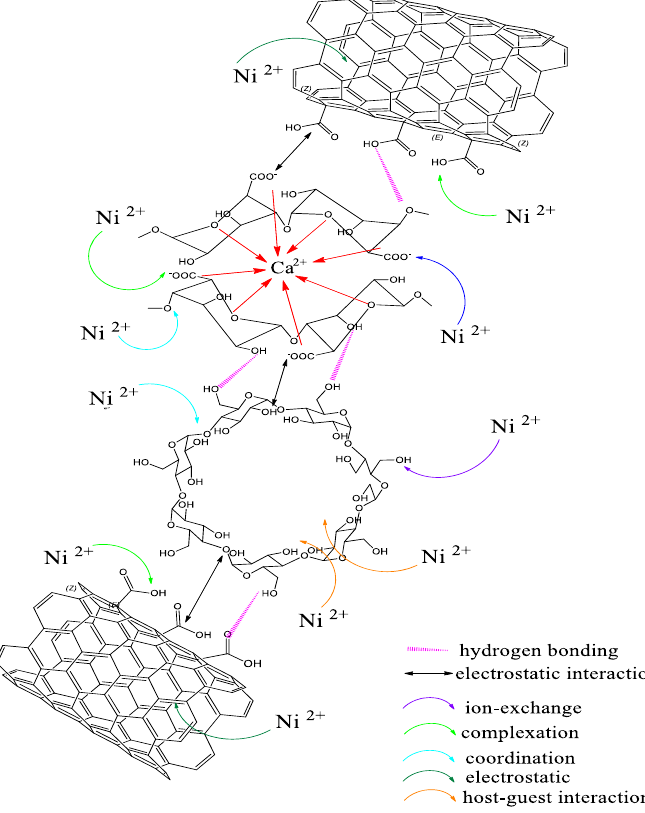
Figure 15. Probable schematic interaction mechanism of the SA −β− CD/CNTs hydrogel adsorbent . 4. Elemental Composition and Distribution on SA ‐β‐ CD/CNTs after Ni(II) Adsorption The elemental study was carried out using FESEM ‐ EDX spectroscopy to confirm the elemental composition of Ni(II), after the adsorption process onto the surface and into the internal surface of SA ‐β‐ CD/CNTs. Figure 16 shows EDXs spectra with three different points used to analyze the Ni(II) sorption properties on each region of the SA ‐β‐ CD/CNTs hydrogel. Based on the mean mass of Ni(II) according to the spectra, a mass percentage of